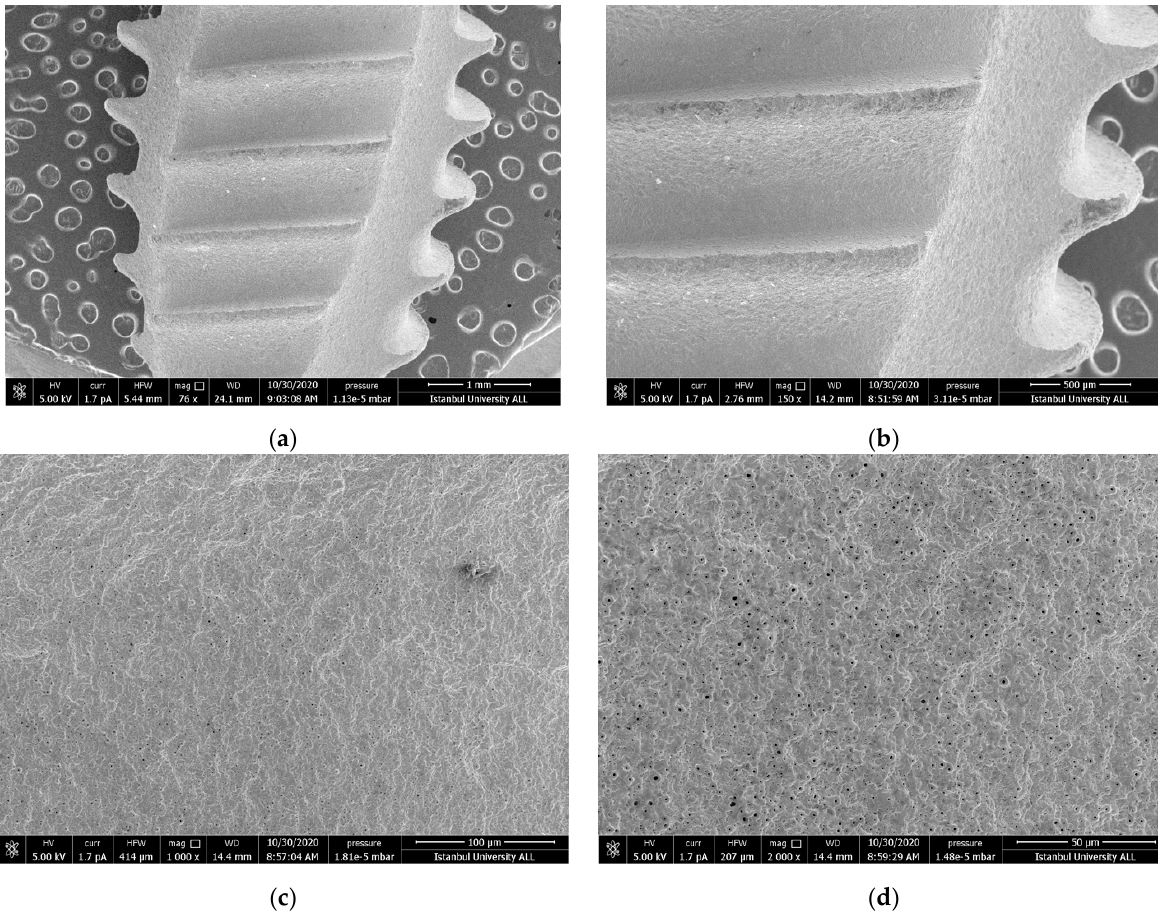
Figure 8. SEM images showing the topography original surface of virgin implant ( a ) 76 × ; ( b ) 150 × ; ( c ) 1000 × ; ( d ) 2000 × magnification.